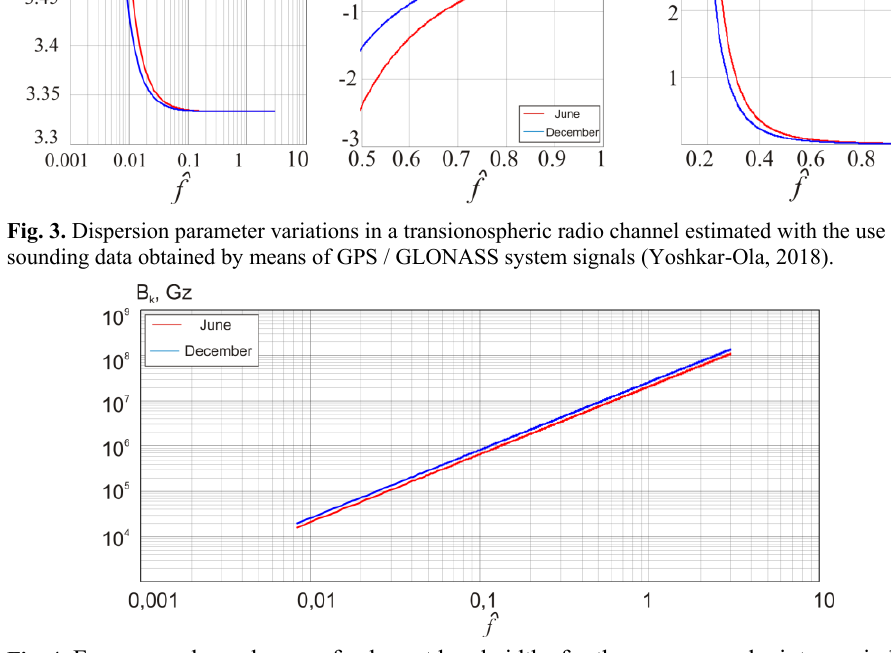
Fig. 4 . Frequency dependences of coherent bandwidths for the summer and winter periods (Yoshkar-Ola,